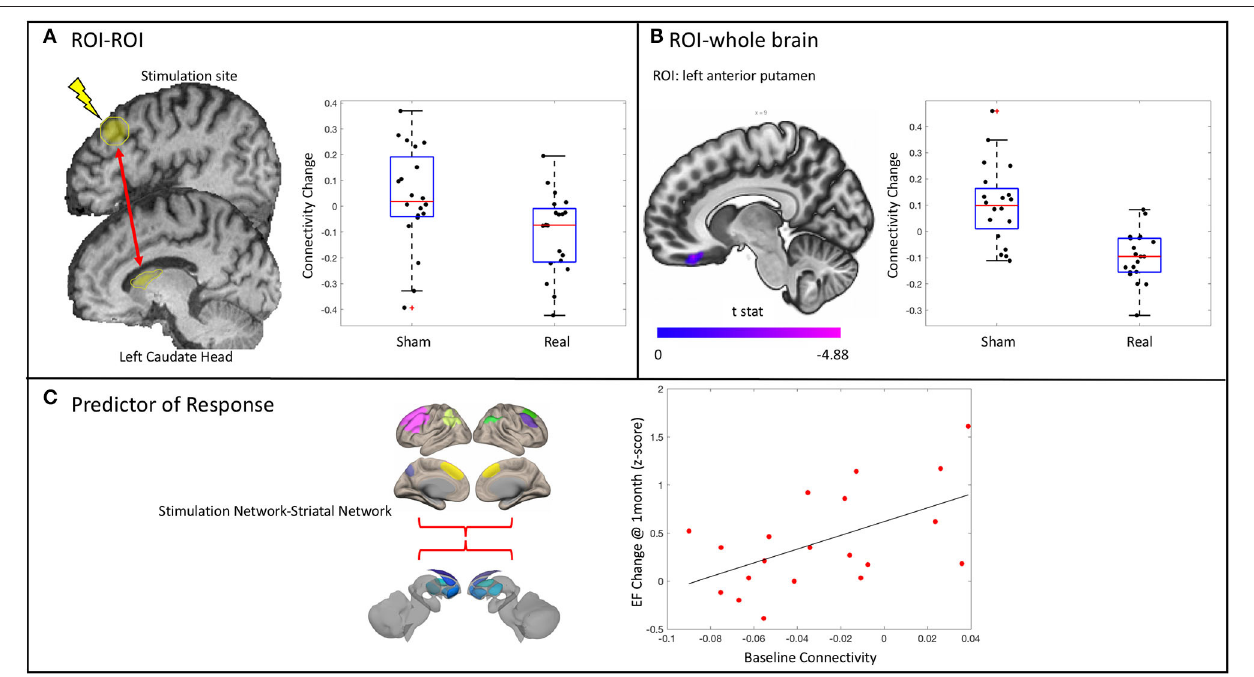
FIGURE 5 | Results from the functional connectivity analysis. (A) A significant decrease in connectivity between the stimulation site and the ipsilateral caudate head in the real stimulation group vs. the sham group as revealed by a significant condition*time interaction. Stimulation site did not change connectivity with any of the other striatal subregions assessed. (B) ROI–whole brain analysis revealed significantly decreased connectivity between the anterior putamen and the right medial orbitofrontal cortex. (C) Baseline connectivity between the stimulation network and the striatal network is related to change in executive functioning (EF) at 1 month in the real stimulation